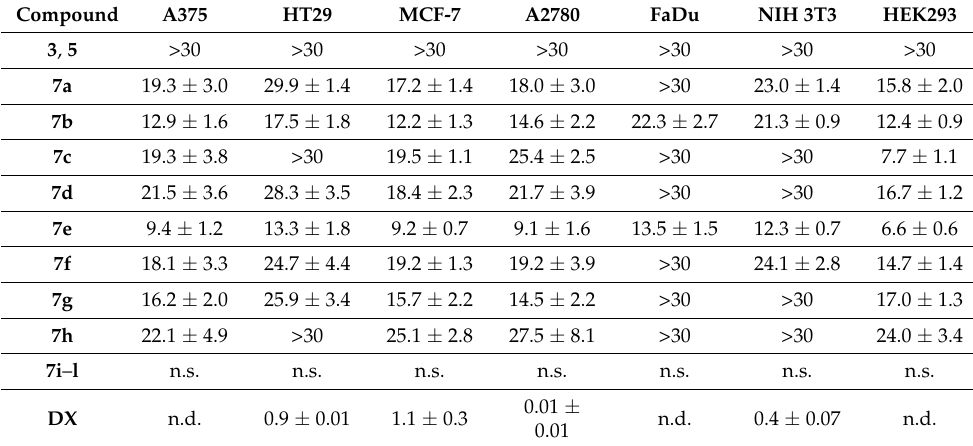
Table 1. Cytotoxicity of compounds 3 , 5 , 7a – l against the human cancer cell lines A375, HT29, MCF-7, A2780, FaDu and non-malignant cells NIH 3T3 and HEK293 (n.d., not determined;n.s., not soluble under the conditions of the assay).